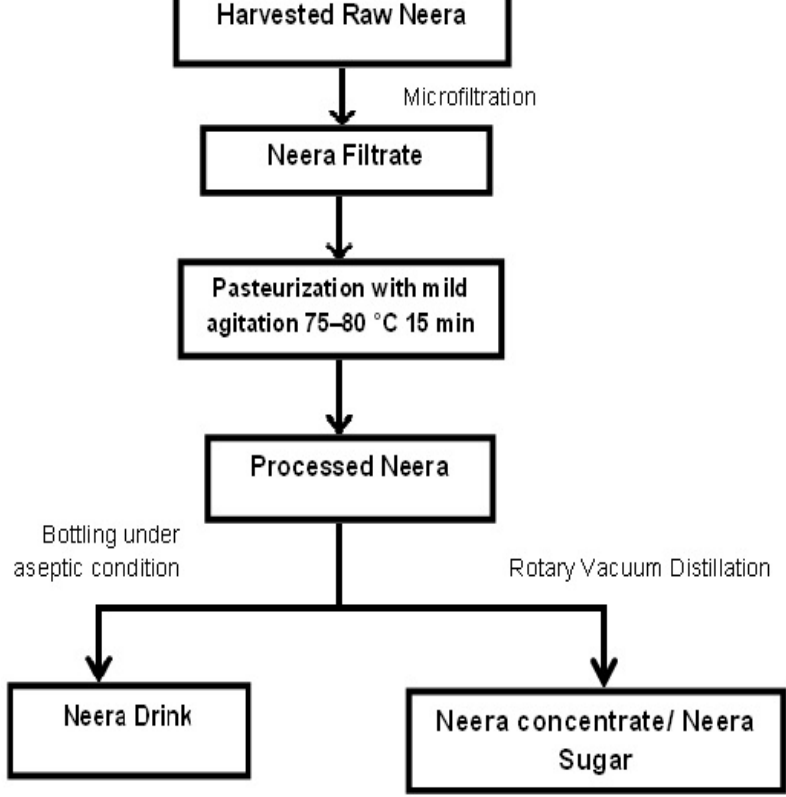
Figure 3. The processing of raw coconut Neera.